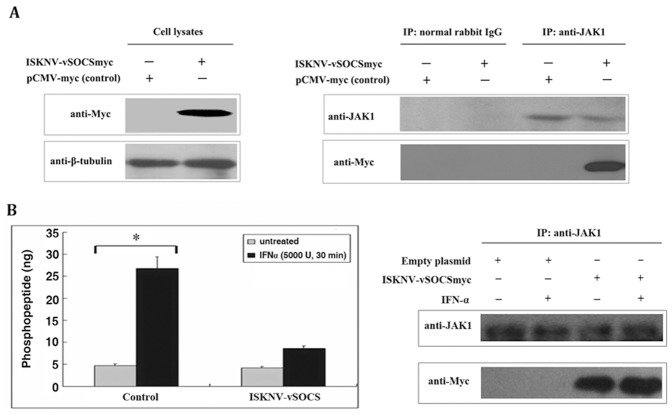
vSOCS interacted with Jak1 protein and inhibited the Jak1 tyrosine kinase activity in vitro.(A) Immunoprecipitation (IP) assay. Cells were transfected with pCMV-myc (empty plasmid) as negative control, or with ISKNV-vSOCS. Myc-tagged protein and tubulin were detected by anti-Myc and anti-β-tubulin antibodies in cell lysates (left plane) after 36 h of transfection. The cell lysates were immunoprecipitated with normal rabbit IgG or anti-Jak1 antibody, and then detected by western blotting using anti-Jak1 or anti-myc antibody (right plane). (B) Direct inhibition of Jak kinase activity by ISKNV-vSOCS in vitro. Cells were transfected with empty vector (control) or ISKNV-vSOCSmyc plasmid, and Jak1 was immunoprecipitated with anti-Jak1 antibody. A part of the immunoprecipitation complex was used to incubate with RTK substrate at room temperature for 1 h (left plane). The rest were detected by Western blotting using anti-Jak1 or anti-Myc antibody. Phosphorylated substrates were detected at an absorbance of 450 nm with a reference wavelength of 655 nm after adding mouse anti-PY20-HRP, TMB solution, and Stop Solution. The gray columns represent the cells without IFN-α stimulation, whereas the black columns represent the cells with IFN-α (5000 U) stimulation for 30 min. One out of six representative experiments is shown. Error bars represent the mean ± S.D. (n = 6). *P<0.05.